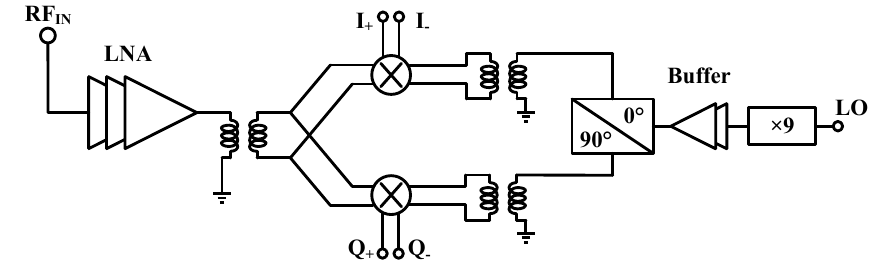
Figure 1. The D-band receiver structure.